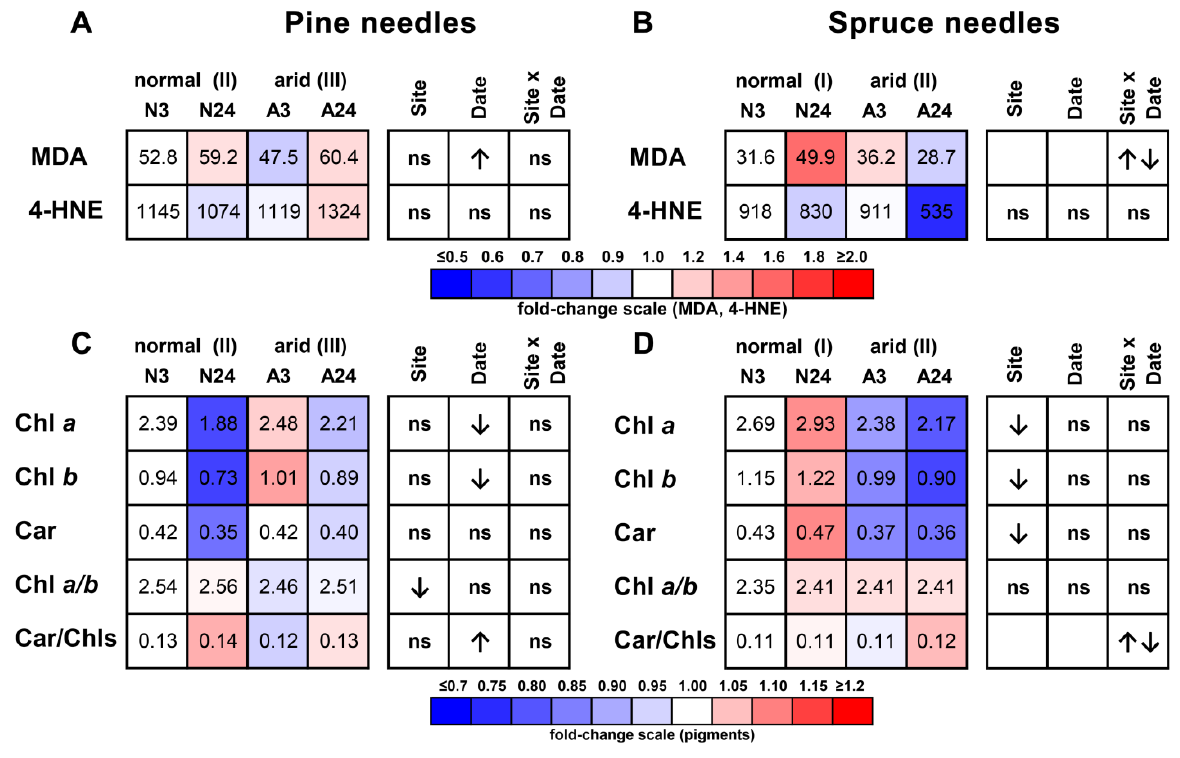
Figure 3. Contents of lipid peroxidation products ( A , B ) and photosynthetic pigments ( C , D ) in pine